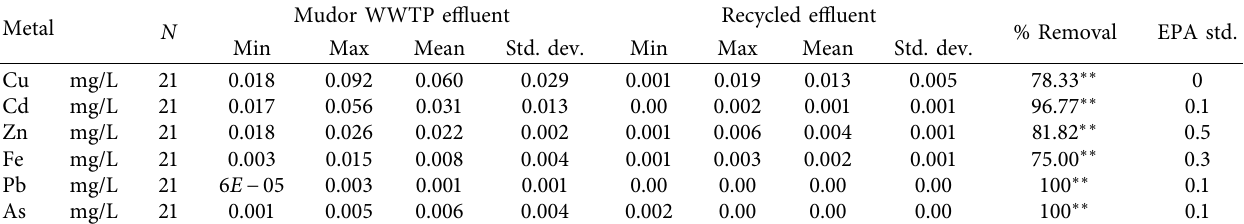
Table 2: Wk 1 mean results for analyzed heavy metal concentration of Mudor and lab-scale setup efuent.